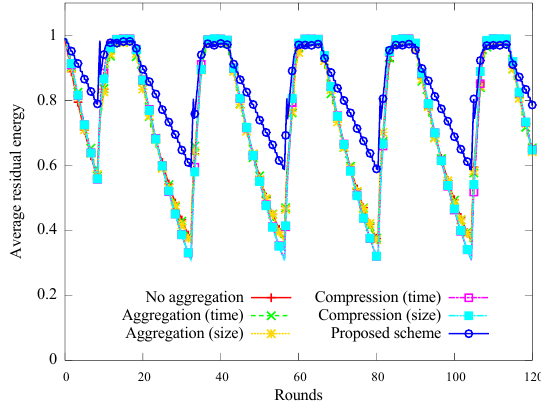
Figure 4. Change in the average amount of residual energy.